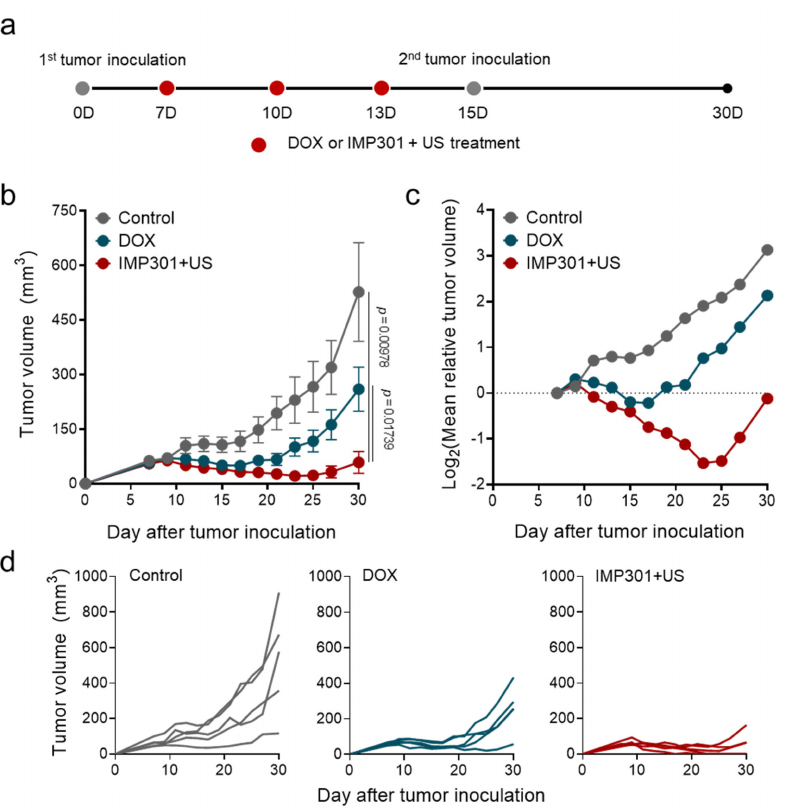
Figure 3. In vivo therapeutic efficacy of the combination of IMP301 and US in 4T1 tumor-bearing mice. ( a ) Schematic illustration of the treatment protocol; ( b , c ) changes in tumor size as a function of time. ( d ) Individual tumor growth in volume ( n =